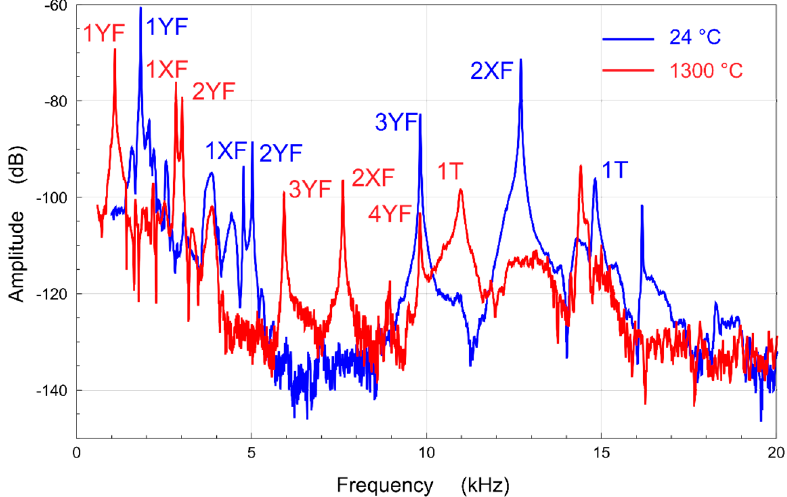
Figure 1. Lower parts (1–20 kHz) of frequency spectra measured from the [001] beam of CMSX-4 at 24 and 1300 °C. T-torsional peaks, and Y- and X-flexural peaks.